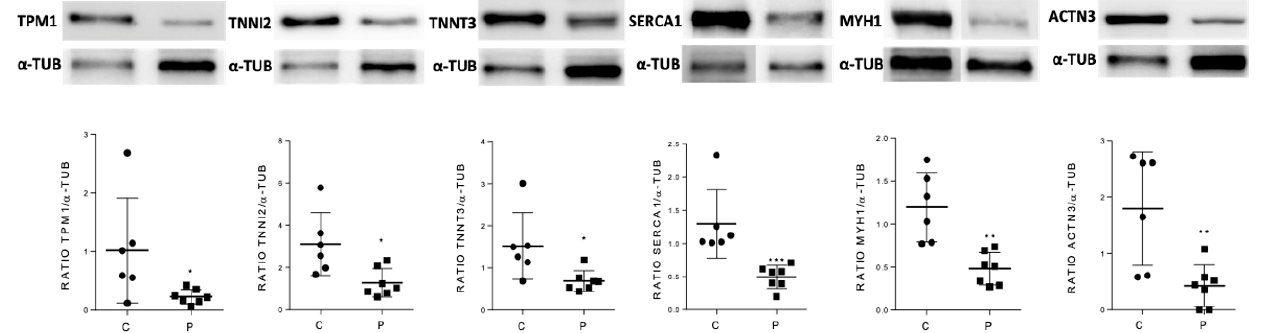
Figure 2. Western blot analysis in skeletal muscle tissue of the candidate proteins that were classified in the ‘very strong’ and ‘strong’ categories in the ‘molecular characterization’ of GSDV by means of artificial neural network analysis. Upper panel: Representative blots from GSDV patients and healthy controls (all patients’ and controls’ Western blots for each candidate protein displayed in Supplementary Figure S1); alpha-tubulin was used as loading control. Bottom panel: Protein levels in GSDV patients (P, n = 7) compared to healthy controls (C, n = 6). * p < 0.05. ** p < 0.01,*** p < 0.001 using Mann–Whitney test. Each dot represents the mean of two quantifications (i.e., two technical replicates). Dispersion lines indicate mean ± SD.